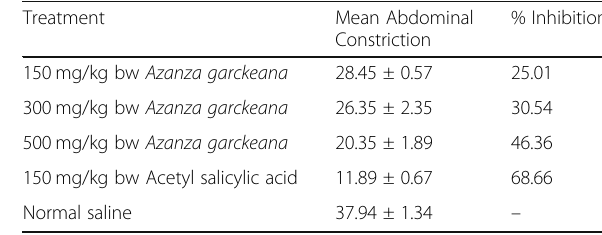
Table 9 Analgesic effects of crude methanol extract of Azanza garckeana